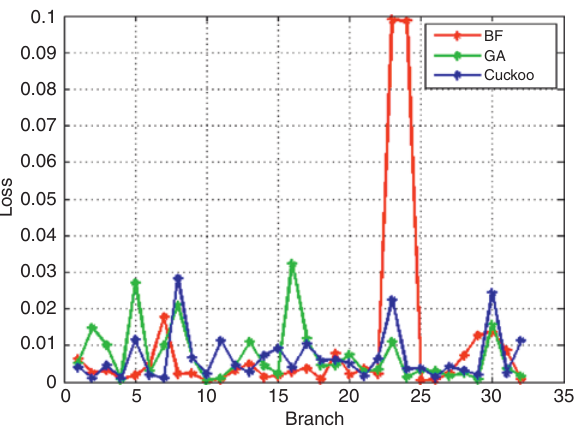
Figure 9: Line Loss Comparison between the Proposed Method and Existing